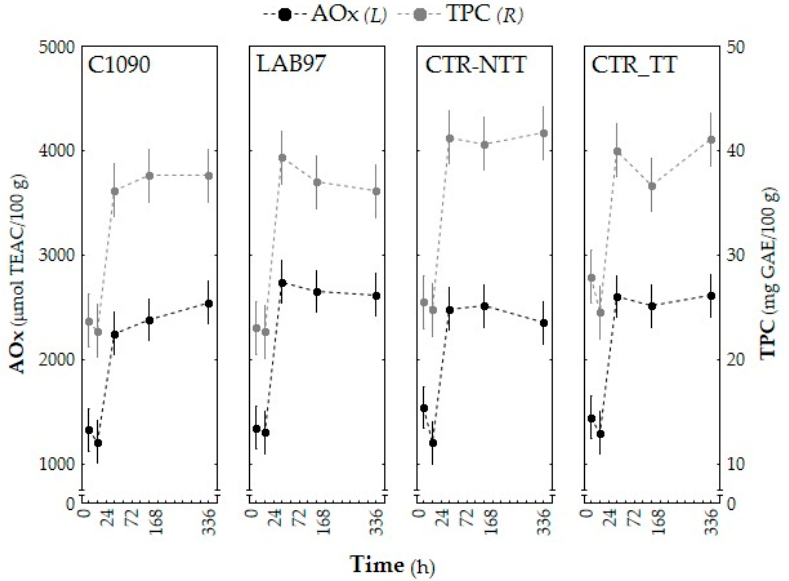
Figure 3. The AOx ( µ mol TEAC/100 g) and TPC (mg GAE/100 g) evolution throughout the lactic acid fermentation of immature tomato pulp samples, which were inoculated with single LAB starter cultures (LAB97 and C1090) and non-inoculated samples (CTR-NTT and CTR-TT) for 14 days. Bars represent the confidence intervals at 95%.